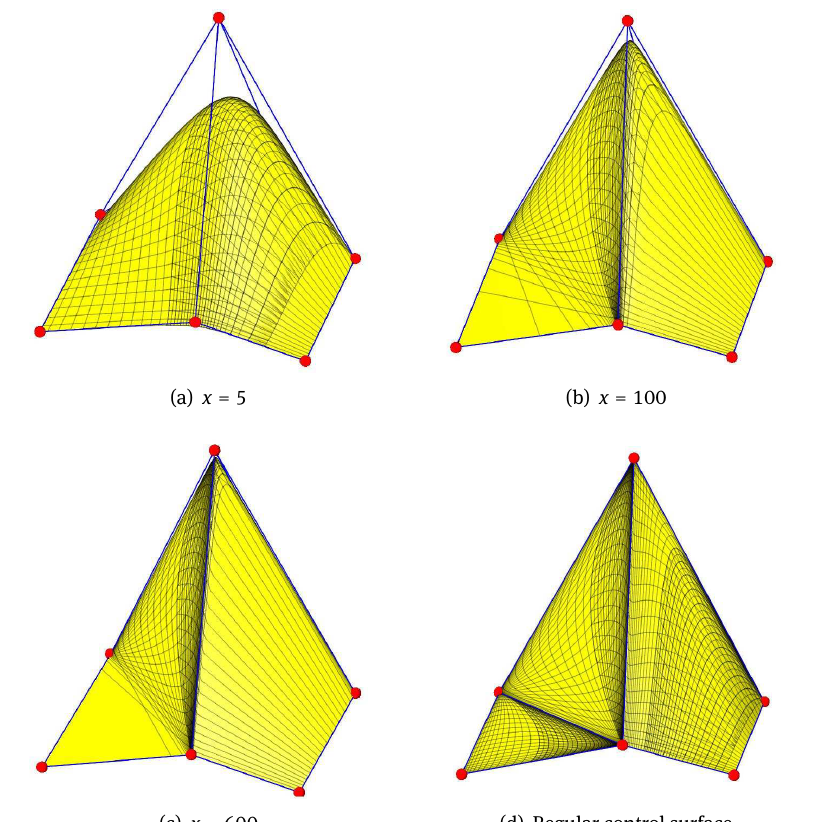
Figure 16: Toric degeneration of GT-Bézier